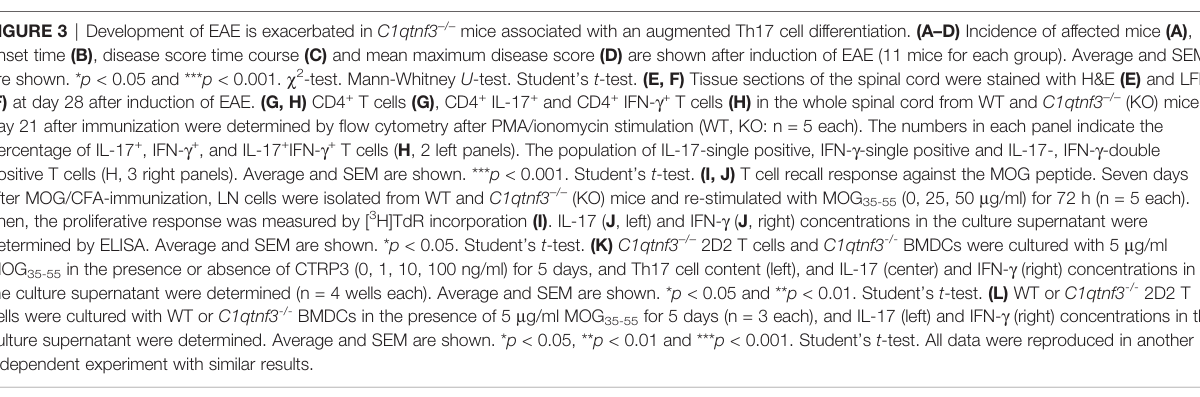
FIGURE 3 | Development of EAE is exacerbated in C1qtnf3 – / – mice associated with an augmented Th17 cell differentiation. (A – D) Incidence of affected mice (A) , onset time (B) , disease score time course (C) and mean maximum disease score (D) are shown after induction of EAE (11 mice for each group). Average and SEM are shown. * p < 0.05 and *** p < 0.001. c 2 -test. Mann-Whitney U -test. Student ’ s t -test. (E, F) Tissue sections of the spinal cord were stained with H&E (E) and LFB (F) at day 28 after induction of EAE. (G, H) CD4 + T cells (G) , CD4 + IL-17 + and CD4 + IFN- g + T cells (H) in the whole spinal cord from WT and C1qtnf3 – / – (KO) mice at day 21 after immunization were determined by fl ow cytometry after PMA/ionomycin stimulation (WT, KO: n = 5 each). The numbers in each panel indicate the percentage of IL-17 + , IFN- g + , and IL-17 + IFN- g + T cells ( H , 2 left panels). The population of IL-17-single positive, IFN- g -single positive and IL-17-, IFN- g -double positive T cells (H, 3 right panels). Average and SEM are shown. *** p < 0.001. Student ’ s t -test. (I, J) T cell recall response against the MOG peptide. Seven days after MOG/CFA-immunization, LN cells were isolated from WT and C1qtnf3 – / – (KO) mice and re-stimulated with MOG 35-55 (0, 25, 50 m g/ml) for 72 h (n = 5 each). Then, the proliferative response was measured by [ 3 H]TdR incorporation (I) . IL-17 ( J , left) and IFN- g ( J , right) concentrations in the culture supernatant were determined by ELISA. Average and SEM are shown. * p < 0.05. Student ’ s t -test. (K) C1qtnf3 – / – 2D2 T cells and C1qtnf3 -/- BMDCs were cultured with 5 m g/ml MOG 35-55 in the presence or absence of CTRP3 (0, 1, 10, 100 ng/ml) for 5 days, and Th17 cell content (left), and IL-17 (center) and IFN- g (right) concentrations in the culture supernatant were determined (n = 4 wells each). Average and SEM are shown. * p < 0.05 and ** p < 0.01. Student ’ s t -test. (L) WT or C1qtnf3 -/- 2D2 T cells were cultured with WT or C1qtnf3 -/- BMDCs in the presence of 5 m g/ml MOG 35-55 for 5 days (n = 3 each), and IL-17 (left) and IFN- g (right) concentrations in the culture supernatant were determined. Average and SEM are shown. * p < 0.05, ** p < 0.01 and *** p < 0.001. Student ’ s t -test. All data were reproduced in